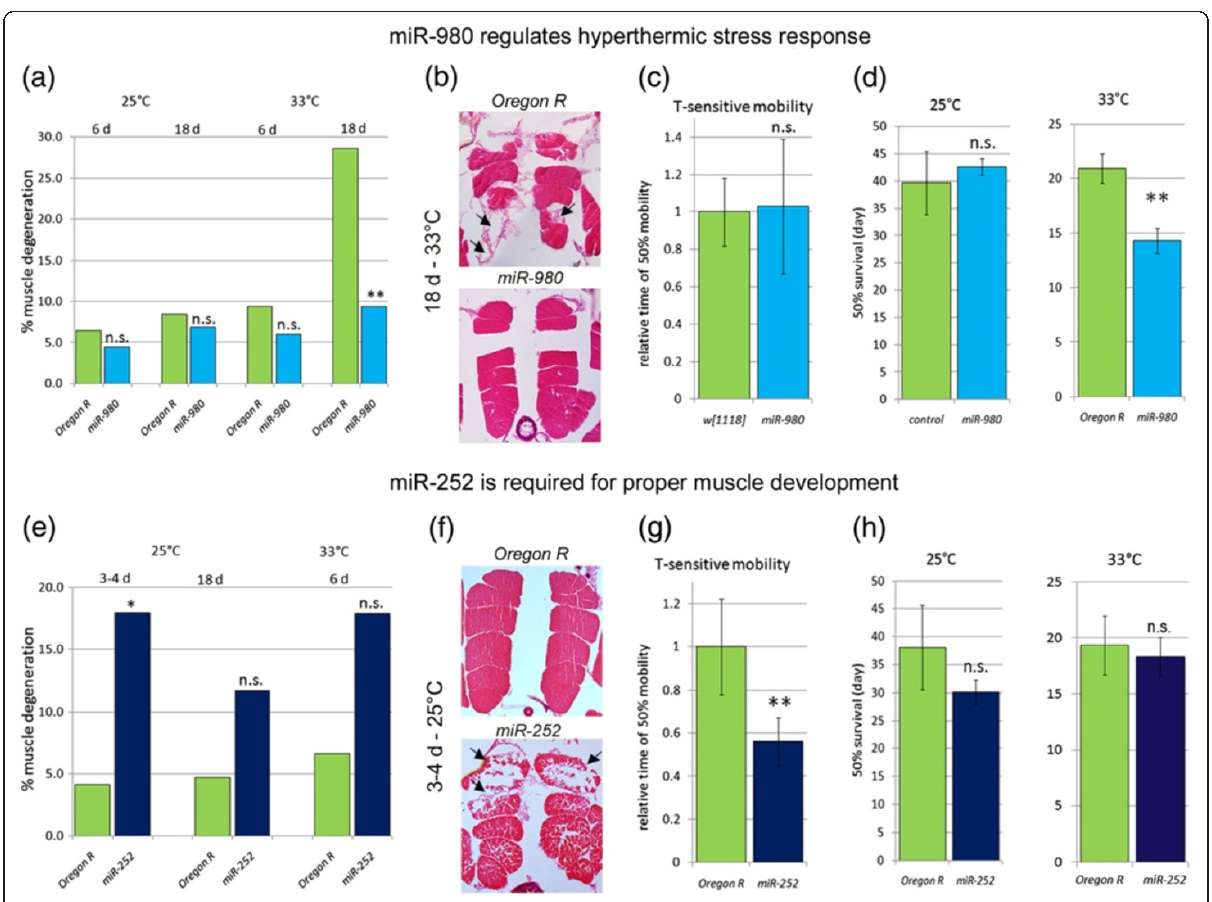
Figure 6 miR-980 is involved in stress response and miR-252 is required for muscle development. ( a ) Muscle degeneration assayed in wt and miR-980 mutants kept for 6 and 18 days at 25°C and 33°C. ( b ) Exemplary histological sections of control and miR-980 muscles after 18 d at 33°C. ( c ) High temperature (~38°C) mobility assay revealed no difference between wt and miR-980 mutants. ( d ) When housed at 25°C, miR-980 mutants did not have a shortened lifespan compared to control w 1118 / OregonR , but at 33°C their lifespan was significantly lower than in wild type animals. ( e ) Muscle degeneration assayed in young, old and stressed wt and miR-252 mutants. ( f ) Exemplary histological sections of control and miR-252 muscles from 3 – 4 d old flies. ( g ) High temperature (~38°C) mobility assay revealed that miR-252 mutants have mobility defects under hyperthermic stress. ( h ) When housed at 25°C and 33°C, miR-252 mutants did not have a shortened lifespan. Muscle degeneration was compared using the Chi-squared statistic where statistical significance of the other assays was done with the Student ’ s two-tailed t-test: *P ≤ 0.05, **P ≤ 0.01, ***P ≤